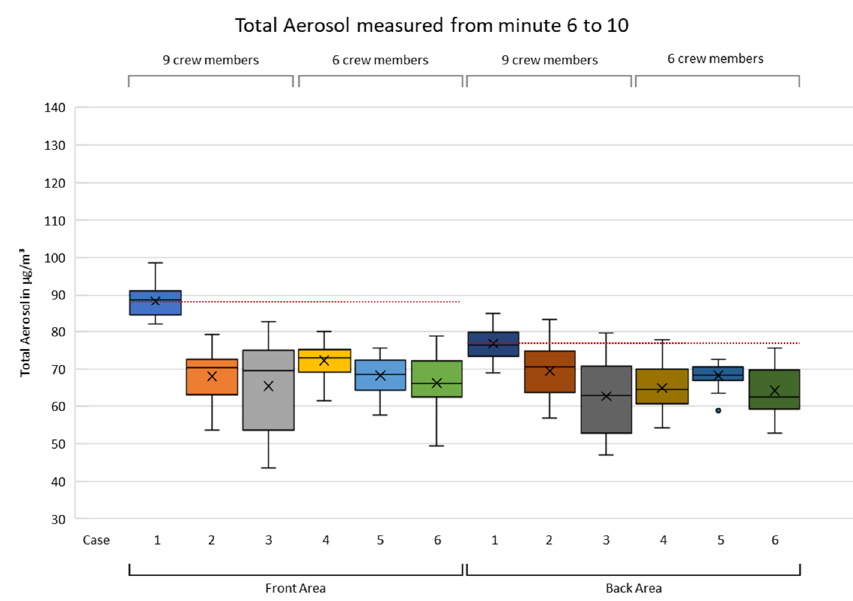
Figure A1. Total aerosol burden measured from minute 6 to 10.